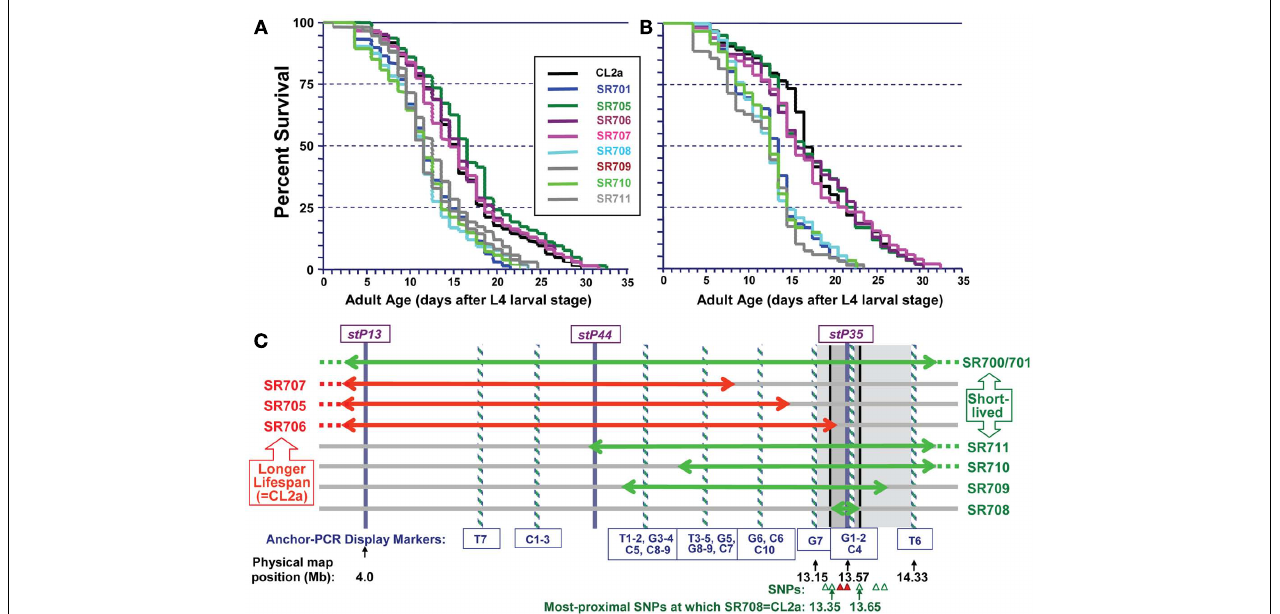
congenic line SR701 and seven recombinants thereof. Long-lived recombinant lines (life-spans similar to CL2a) are named at the left, while those named on the right were shorter-lived.The 26 new markers obtained by Anchor-PCR Display, and three previously determined markers in this vicinity (Williams et al., 1992), were ordered into 10 groups by the seven recombinant lines; eight of these are indicated by cross-striped vertical bars. Based on these data, the longevity QTL lies between marker groups G7 and T6 (shaded rectangle, 13.15–14.33Mb). Several of the SNPs in this region that distinguish between parental strains are indicated by triangles at the figure bottom; symbols are green/open if SR708 carries the CL2a allele; and red/filled if SR708 carries the Bergerac-BO allele. SNPs shown here, named forYAC clones in which they reside, are: snp_Y67H2A (13.27Mb), snp_W02A2/pkP4053 (13.35Mb), snp_Y45F10A/pkP4059 (13.49Mb), snp_Y45F10B (13.55Mb), snp_Y45F10C (13.65Mb), snp_Y37A1A (13.83), and snp_C27H2 (13.95). SNPs with “pkP” are